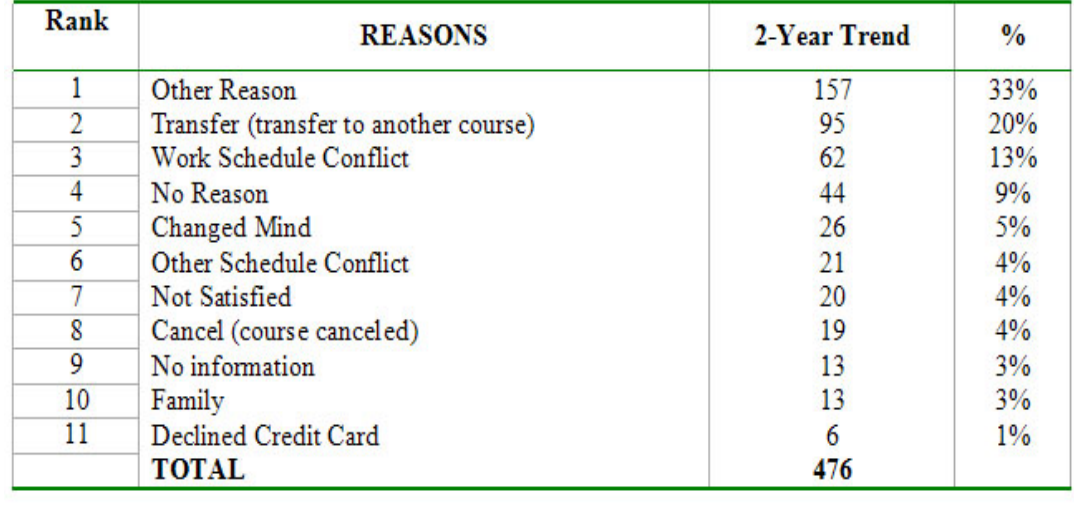
Table 7 . Reasons given for requesting withdrawal from online